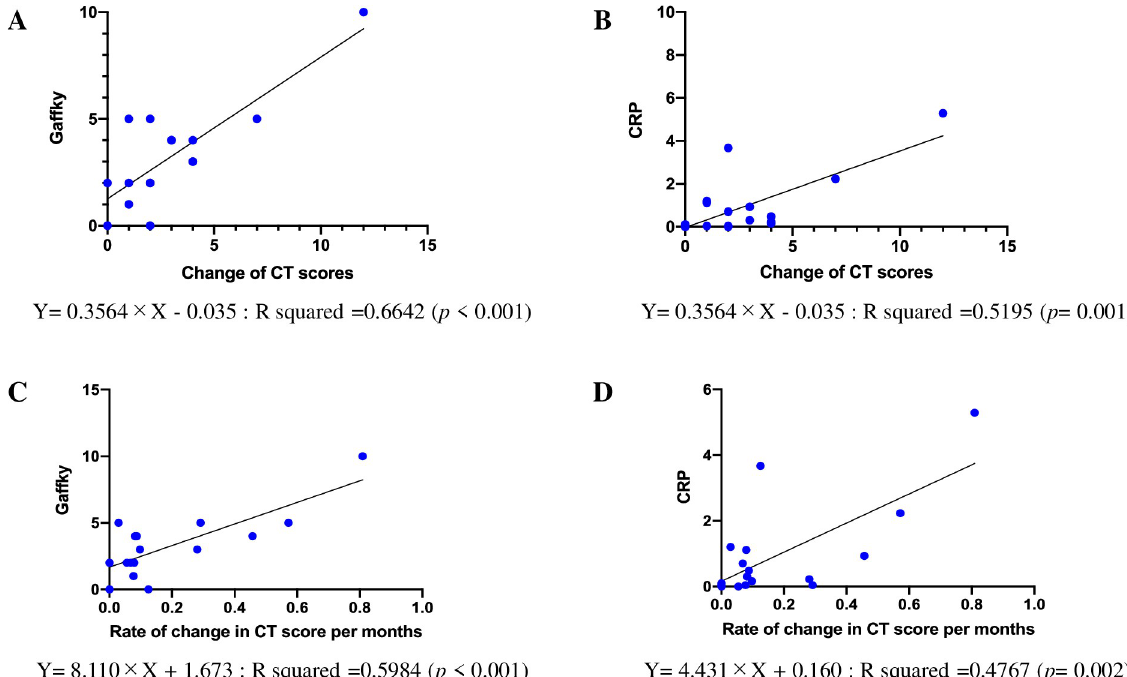
Fig 2. Relationship between chronological change in CT score and sputum Gaffky score, serum CRP. Correlation between the difference of CT scores with sputum Gaffky score (Fig 2A) and CRP (Fig 2B) are shown. The change rate in CT score was also correlated with sputum Gaffky score (Fig 2C) and CRP (Fig 2D),